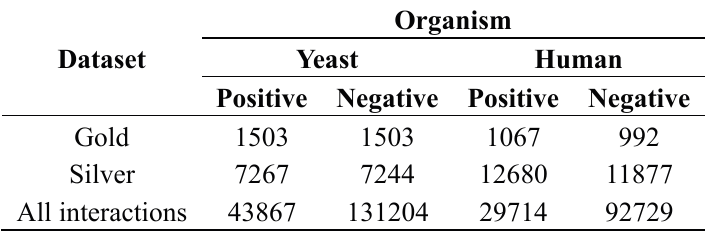
Table 5. Details of the Gold, Silver, and All Interaction